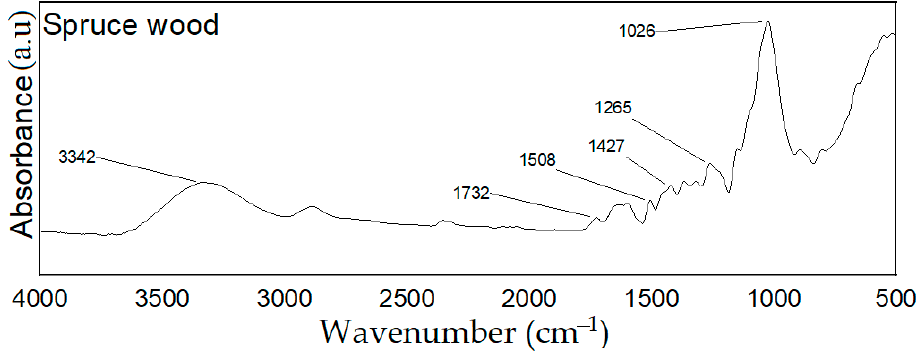
Figure 5. FTIR-ATR spectra of spruce wood (Control).